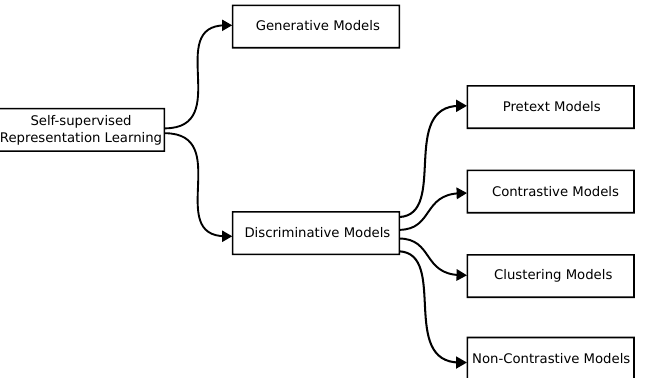
Figure 1. A taxonomy of SSRL models, adopted from that proposed by Deldari et al.